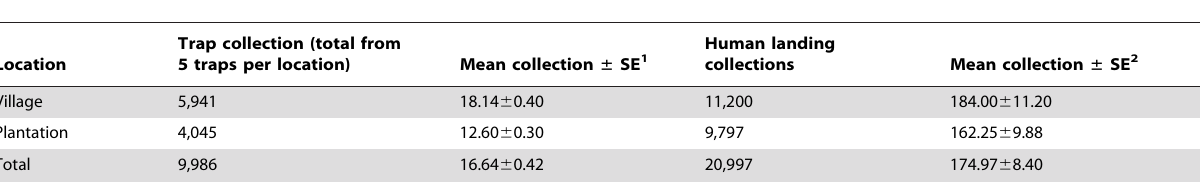
Table 1. Mean 6 standard error (SE) of the daily number of Simulium ochraceum s.l. captured over 60 days.